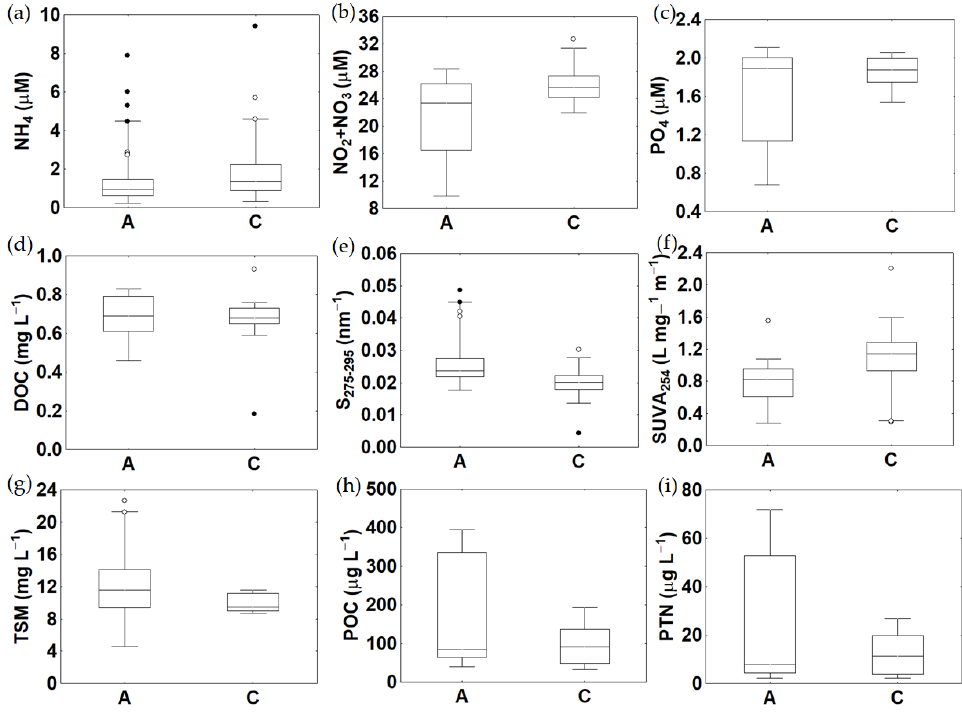
Figure 4. Mean concentrations of trophic and optical variables in the two different study areas: ( a ) ammonia NH 4+ ; ( b ) nitrite+ nitrate NO 2 +NO 3 ; ( c ) phosphate PO 4 ; ( d ) dissolved organic carbon DOC; ( e ) slope in the range 275 – 295 nm S 275 − 295 ; ( f ) SUVA 254 index; ( g ) total suspended matter TSM; ( h ) particulate organic carbon POC; ( i ) particulate nitrogen PTN. Box-Whiskers plot: boxes are characterized by a median line and boundaries indicating 25 th and 75 th percentiles; whiskers are characterized by a vertical line indicating 5 th and 95 th percentiles. White dots = outliers, black dots = extreme values.